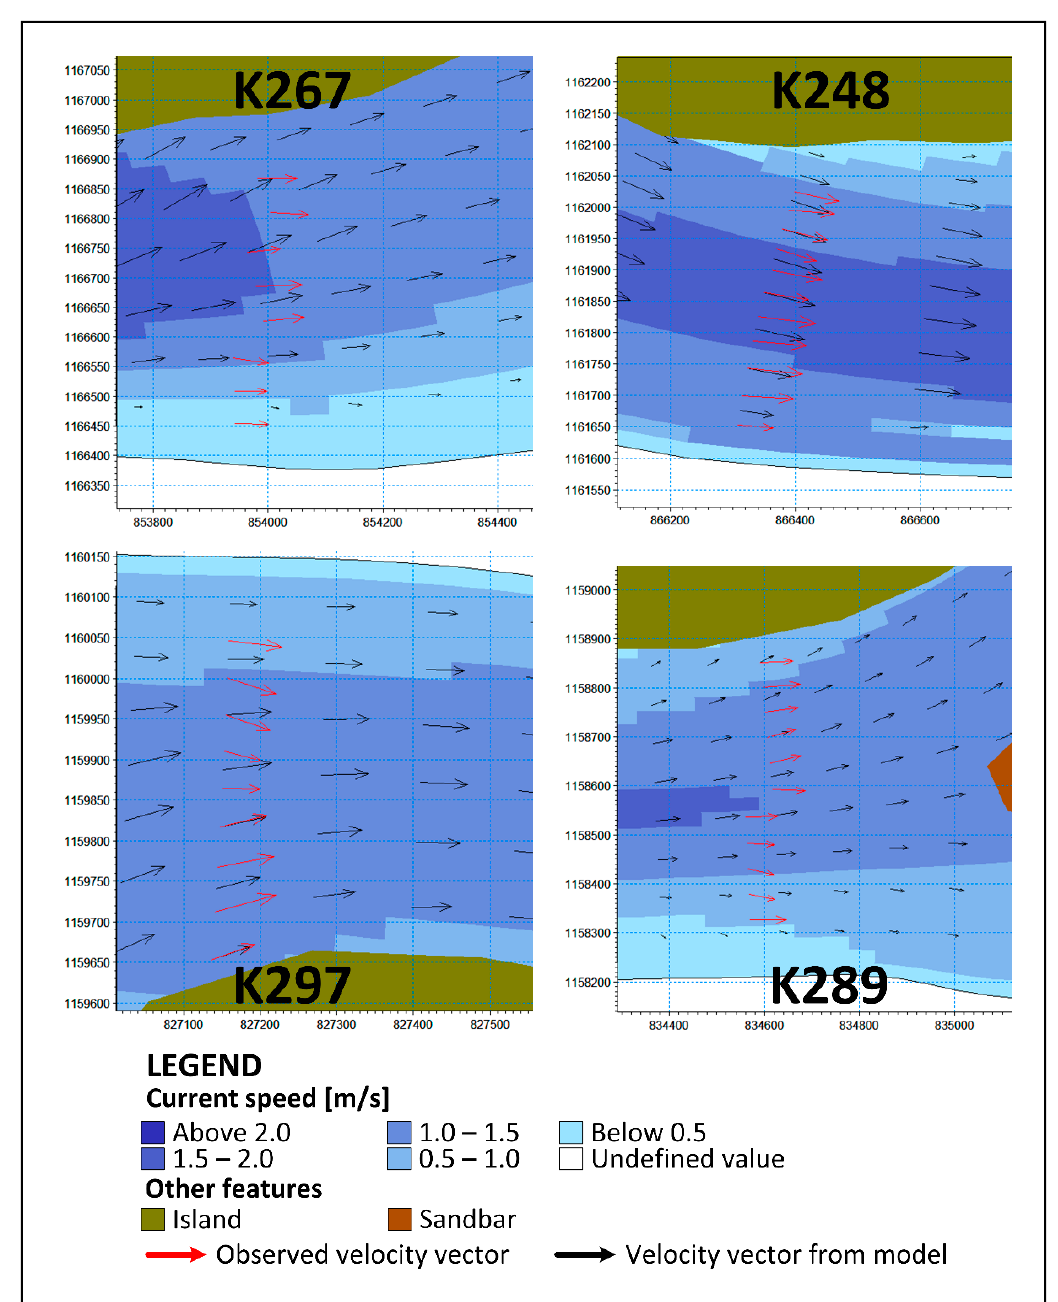
Figure 3. Velocity vectors from the model for hydrodynamic calibration.